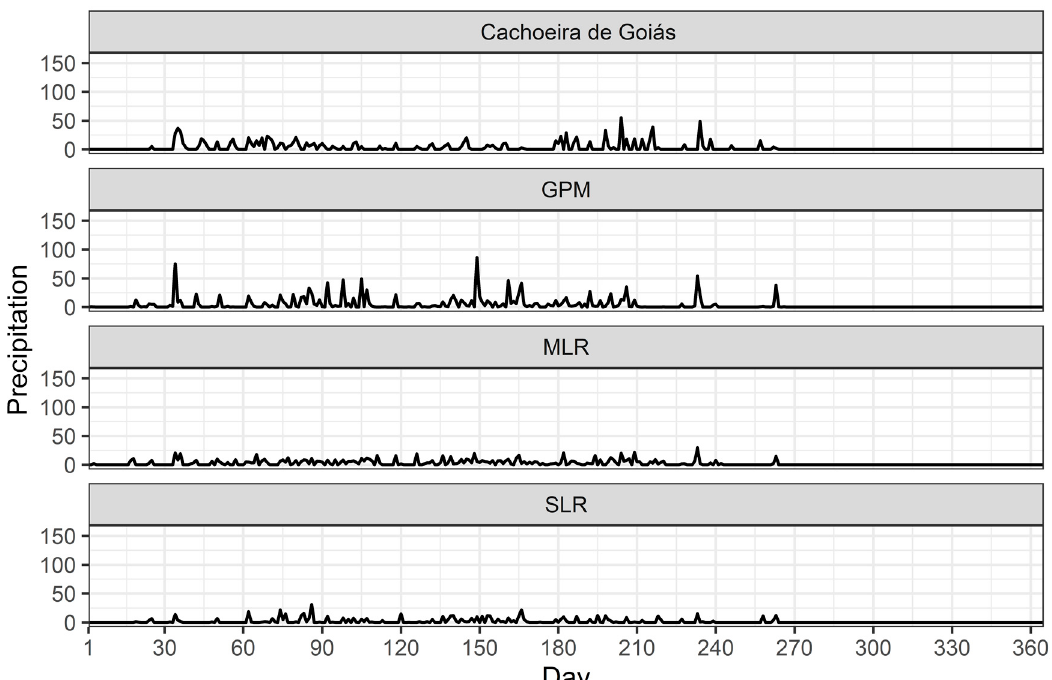
Figure 4. Direct comparisons between daily precipitation estimates and observed data for the period from 1 September 2016 to 31 August 2016 at the Cachoeira de Goiás station. OBS, observed data; MLR, multiple linear regression method; SLR, simple linear regression; GPM, Global Precipitation Measurement method.